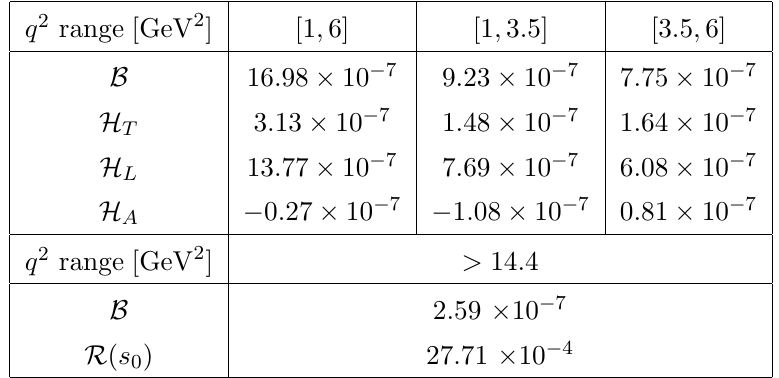
Table 5 . Phenomenological results without electromagnetic e(cid:11)ects, i.e. log-enhanced QED correc- tions to the matrix elements at the scale (cid:22) b are not included. The smaller e(cid:11)ect of QED corrections in the matching and running is, however, taken into